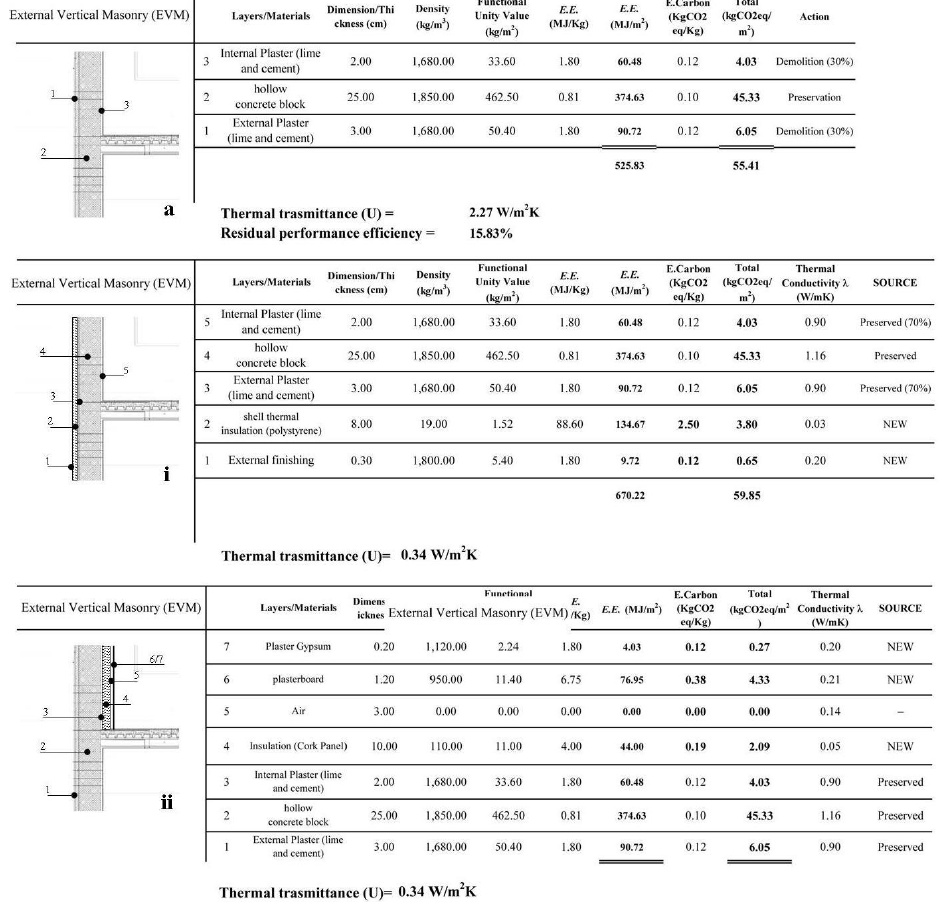
Figure 11. External vertical masonry: current status ( a ); with external insulation ( i ); with internal insulation ( ii ).